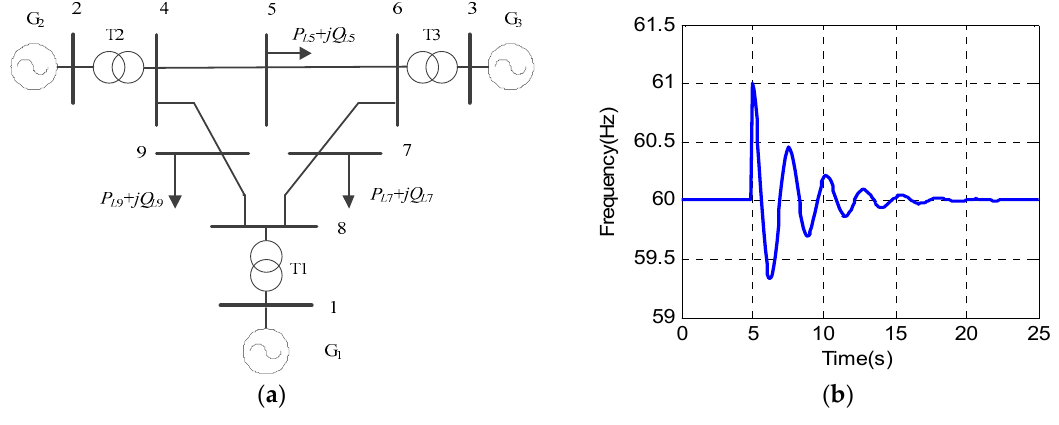
Figure 8. ( a ) The model of WSCC power system; ( b ) The input signal of test system 3.